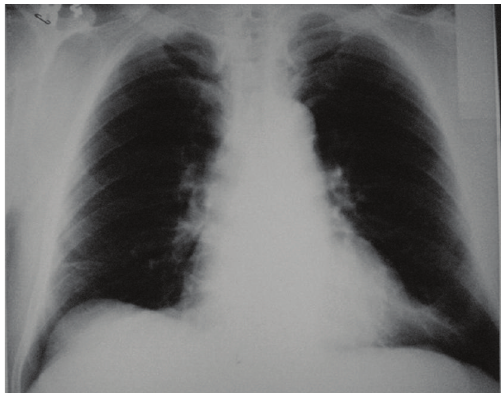
F 1: Chest radiography showing pleural effusion with linear atelectasis on the right lung.